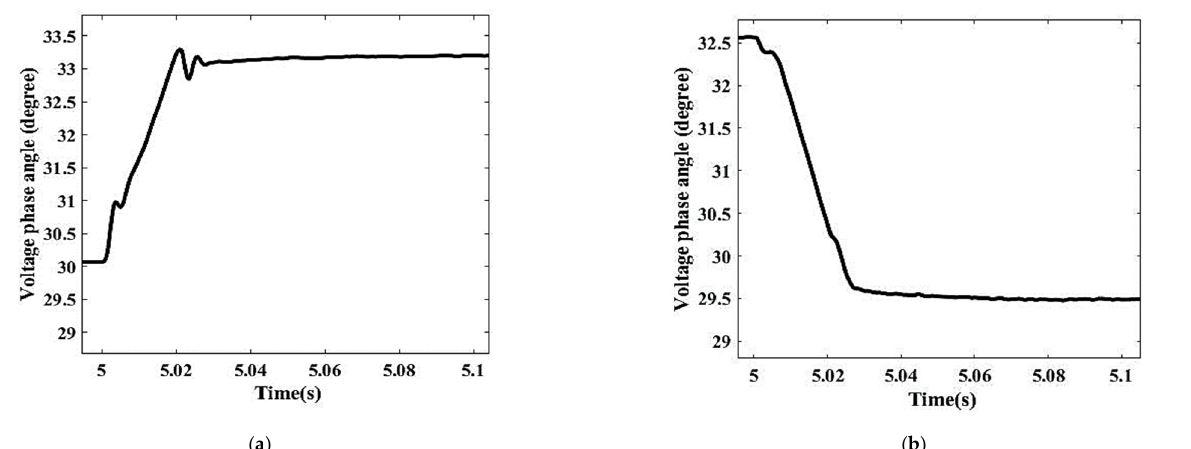
Figure 8. Magnitude of voltage phase angle during load switching scenarios ( a ) load increment ( b ) load decrement.